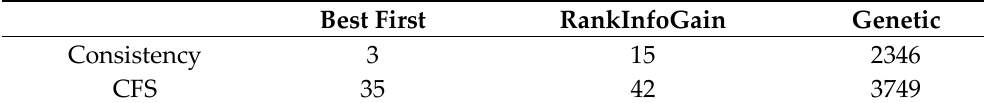
Table 9. Number of features selected.